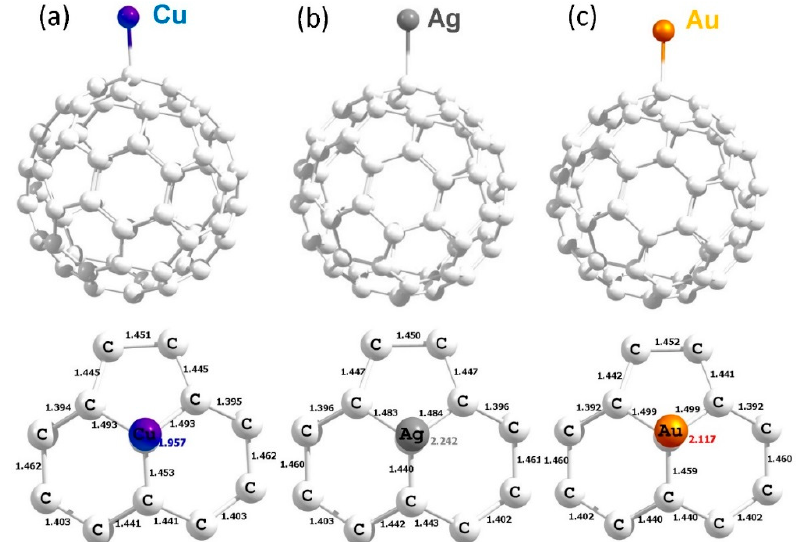
Figure 5. Optimised structures of Cu ( a ), Ag ( b ) and Au ( b ) adsorbed on the surface of C 60 .